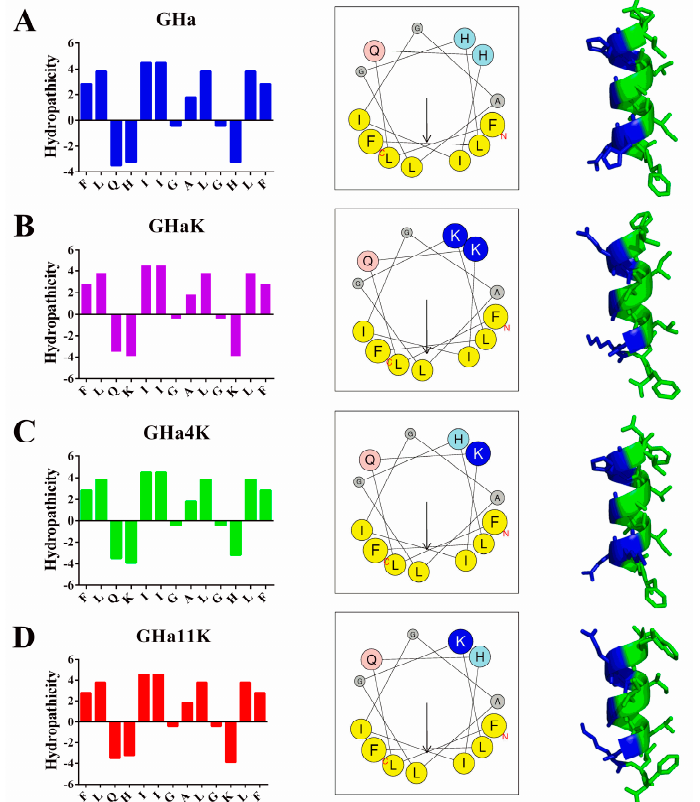
Figure 1. The distribution of hydrophilic and hydrophobic amino acid residues, helical wheel projection and the predicted 3D structures. The four rows of ( A ), ( B ), ( C ), and ( D ) are GHa, GHaK, GHa4K, and GHa11K. The left column showed the amphipathic profile calculated by the ExPASy. The middle column showed the helical wheel projection of the peptides generated by using the Heliquest (http://heliquest.ipmc.cnrs.fr/). The arrows indicated the direction of the hydrophobic moment. The right column demonstrates the 3D structure, analyzed by using PEP-FOLD (http://bioserv.rpbs.univ-paris-diderot.fr/services/PEP-FOLD/), with a hydrophilic surface in blue and a hydrophobic surface in green.